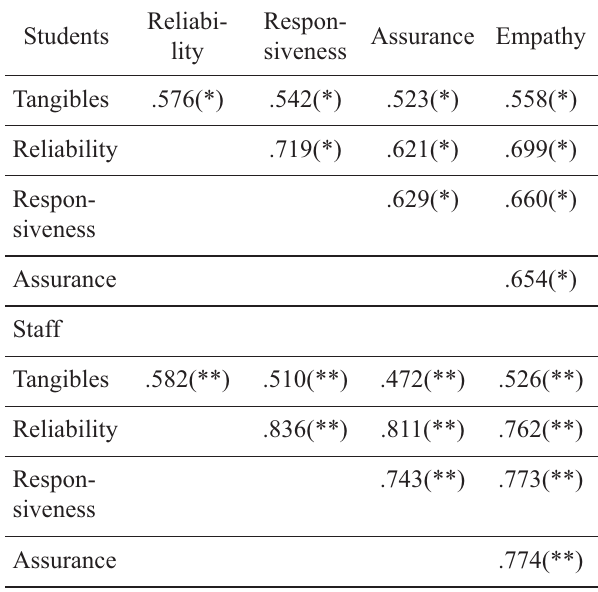
Table 3. Pearson correlation coeffi cients